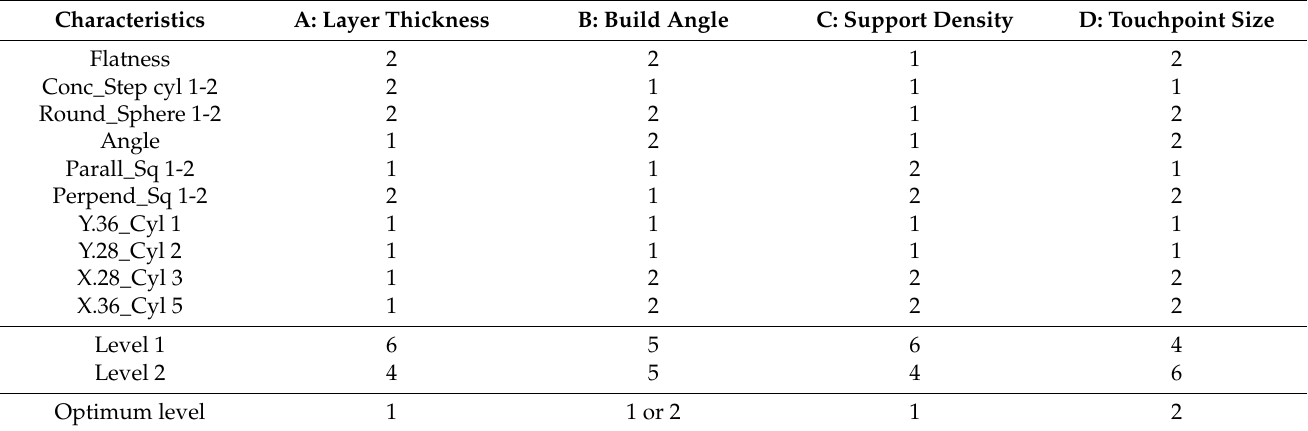
Table 21. Optimum levels of parameters for geometric characteristic of cast parts.